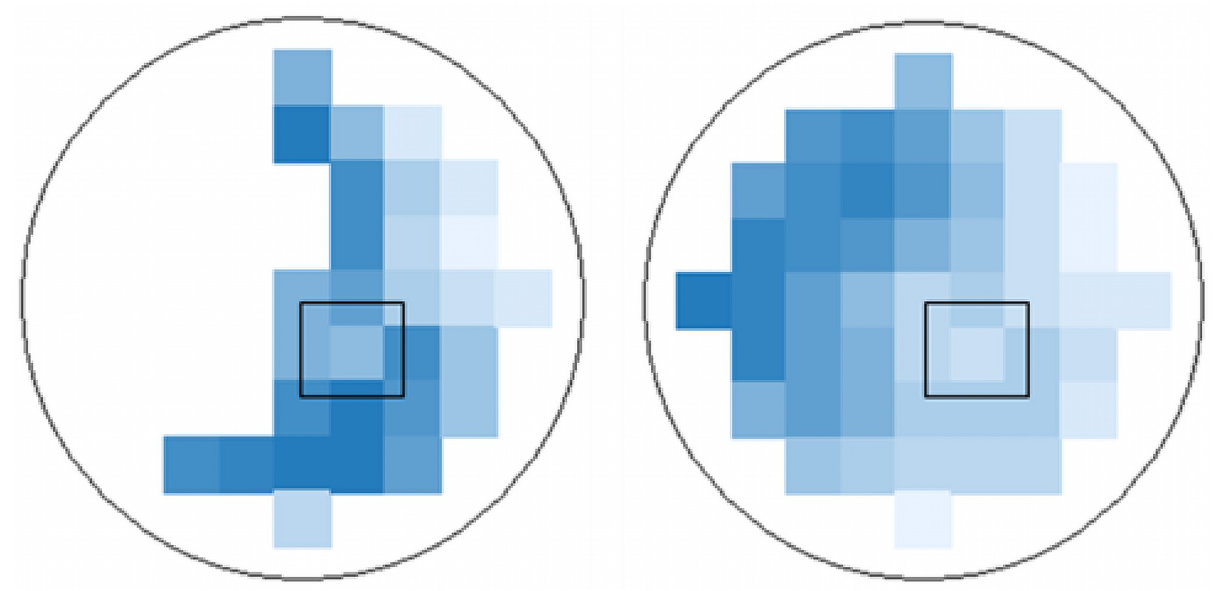
Fig 8. Heat map (9x9 matrix) of sample 1 at 380 nm (left) and 460 nm (right). The point with the least absorption (ROI) is marked in black. No light was transmitted at lower wavelengths in large parts of the sample.